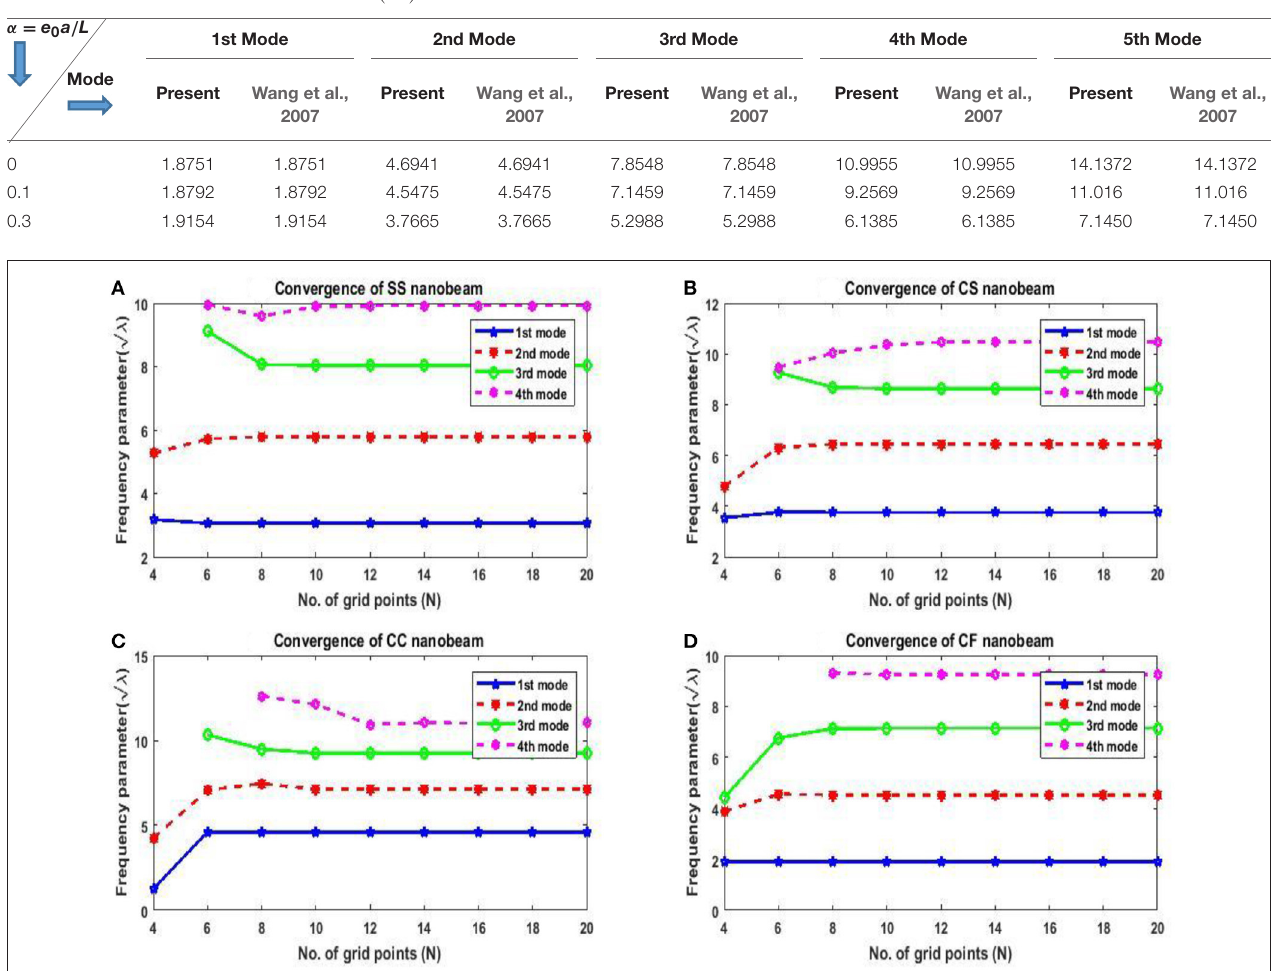
√ λ for CF case. (cid:16) (cid:17)